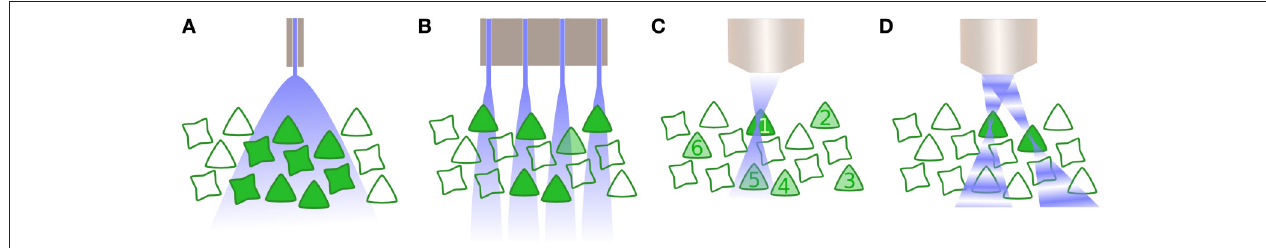
FIGURE 2 | Activating neurons to drive activity. (A) Whole field illumination via diode, either located at the cortical surface or inserted within the tissue. In both instances, all neurons within the illuminated area are activated. (B) An array of photodiodes illuminates subpopulations in the lateral plane, illustrated here in combination with opsin specificity for only one class of neuron. However, targeting is not constrained in the axial dimension and likewise drives multiple neurons within a column corresponding to each individual diode. (C) Multiphoton excitation results in a spatially constrained point spread function (PSF) in lateral and axial planes. Here, the 2P beam is targeted for the first neuron, whose soma is significantly larger than the PSF thus requiring scanning the neuron and increasing the dwell time. Driving other selected neurons within the population (2–6) is performed sequentially. (D) Digital holography utilizes wavefront shaping, in which a spatial light modulator alters the phase of beams in order to create multiple PSFs, allowing multiple neurons to be simultaneously but independently